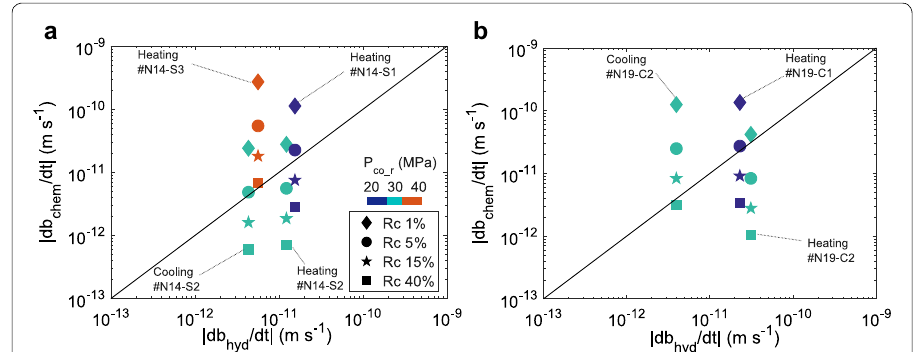
Fig. 10 Fracture closure rates. Comparison between the rates of hydraulic aperture reduction, d b hyd / d t , and the chemical rates of aperture reduction, d b chem / d t , for four different estimated fractional contact areas: 1% (black diamond), 5% (black circle), 15% (black star), and 40% (square). a Step‑wise heating experiments ( # N14‑S1, # N14‑S2, and # N14‑S3), with Specimen N14 under 3 different stresses (20, 30, and 40 MPa). b Constant‑rate heating experiments ( # N19‑C1, # N19‑C2), with Specimen N19 under 2 different stresses (20 and 30 MPa). Only the cycles that represent closure (i.e., originally negative rate) are